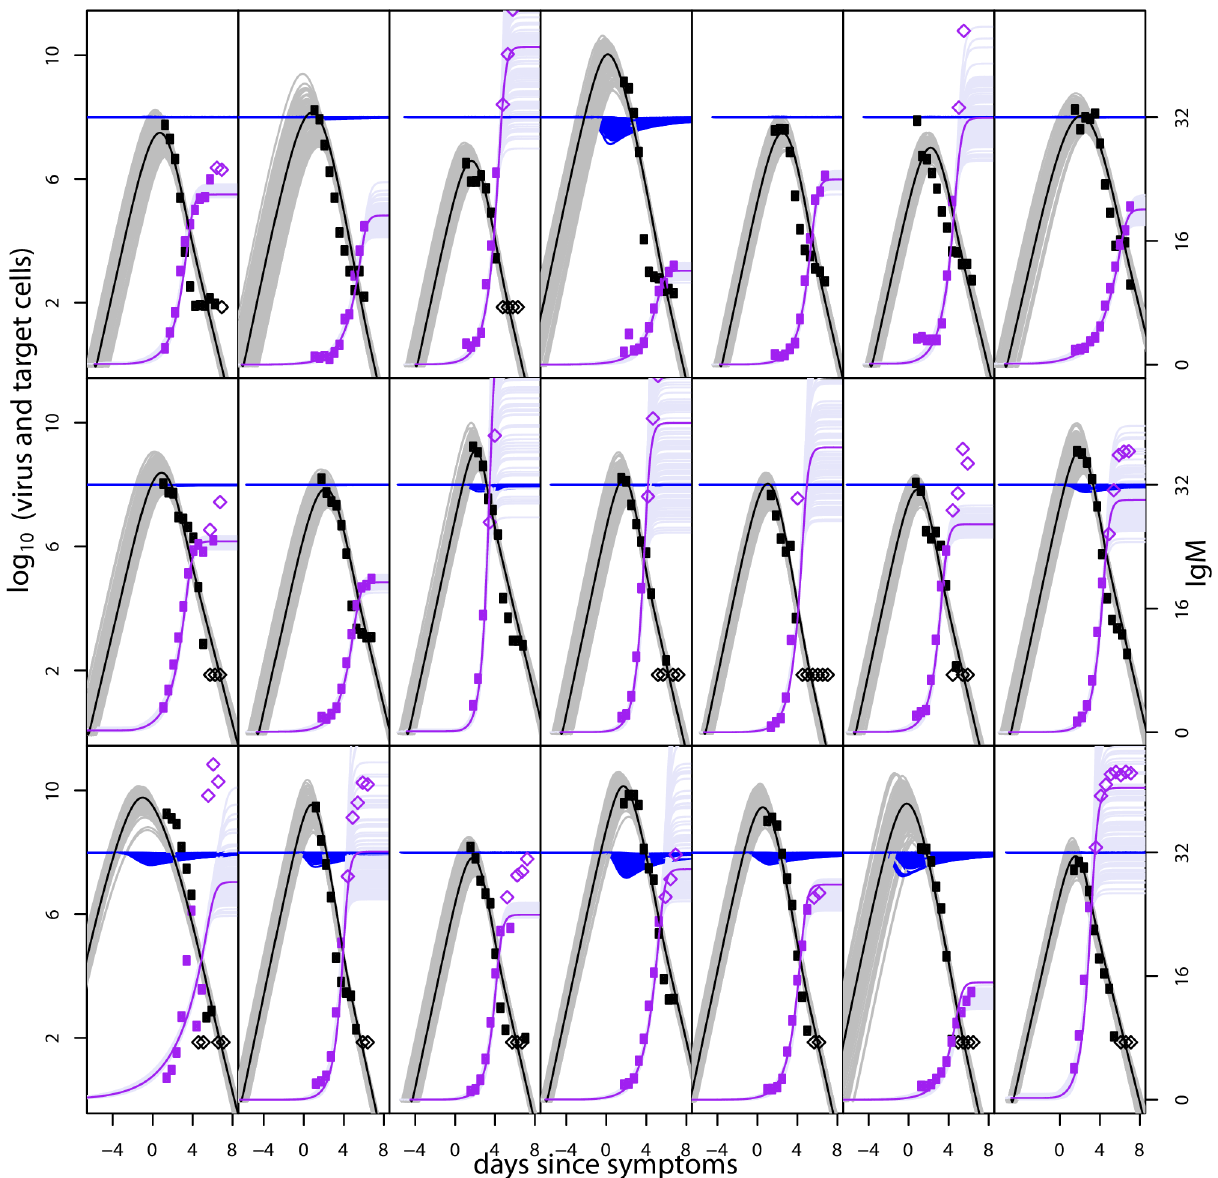
Fig 6. As Fig 5 but for DENV2-infected subjects. Fit of the model to virus and IgM measurements for DENV1-infected subjects for the ADCC model variant. Each plot shows an individual patient. Virus data is shown in black and IgM data in purple. Parameters z 0 , η 1 , η 2 , IP and SF fitted as patient specific, other parameters fitted per group. Mauve, grey and blue curves show 100 samples from the posterior distributions of antibody, virus and target cell trajectories, respectively. Median fits are shown as bold lines (purple shows IgM, black shows virus). Parameter estimates are shown in Table 3. All subjects were classified as secondary